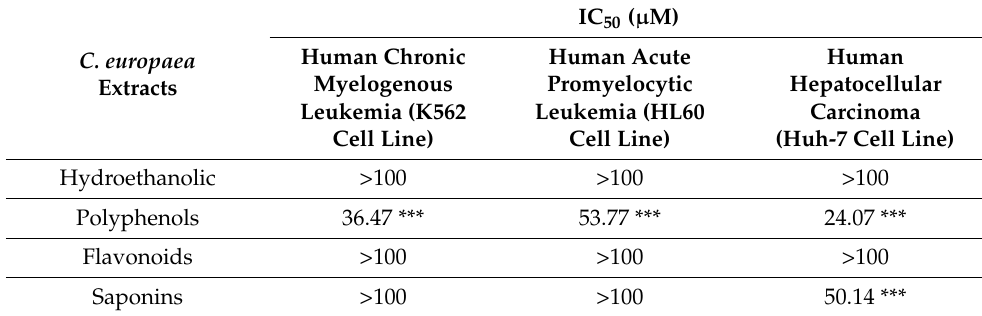
Table 2. Anticancer activity of the C. europaea